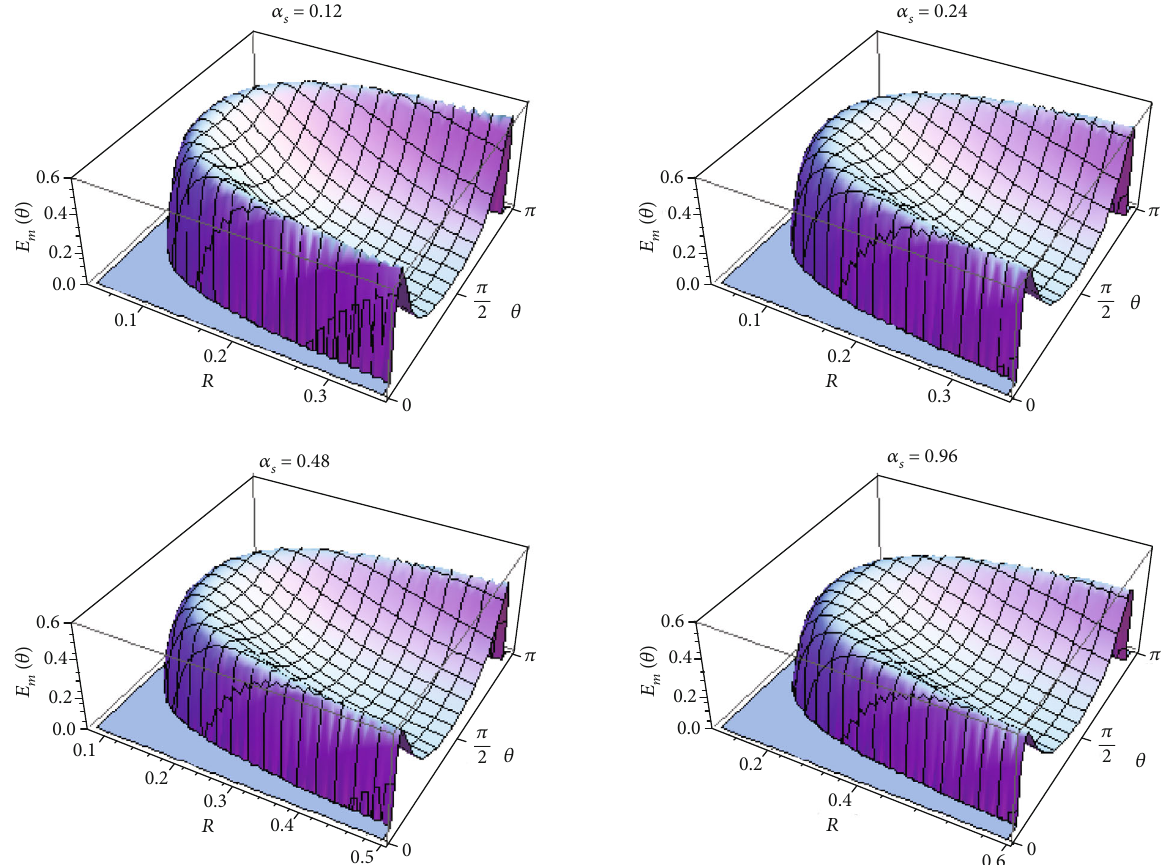
Figure 3: (color online) 3d pro fi les of color electric fi eld E